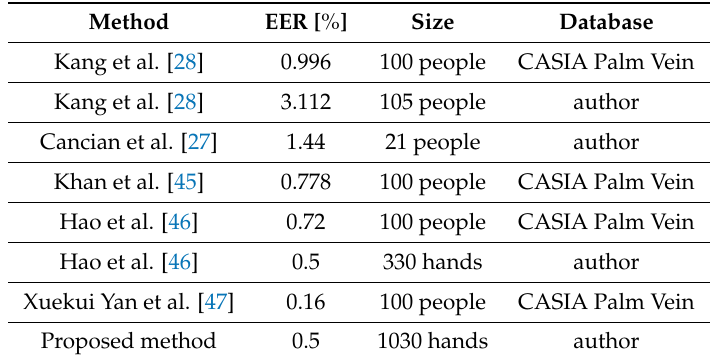
Table 3. Comparison of